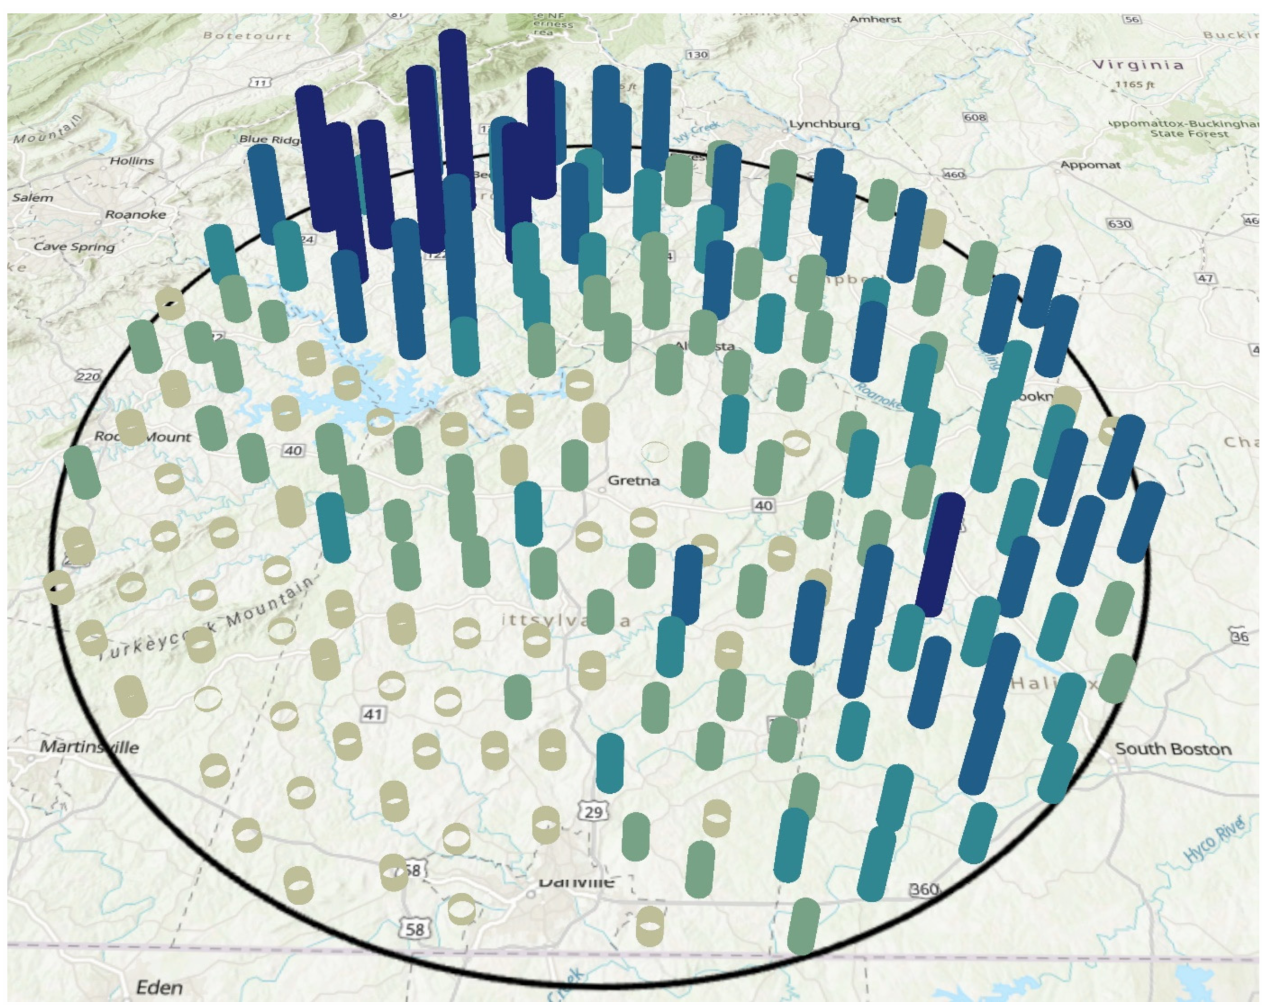
Figure 1. An extrusion map showing the relative feedstock production that is harvested and stored in the 199 SSLs around Gretna,